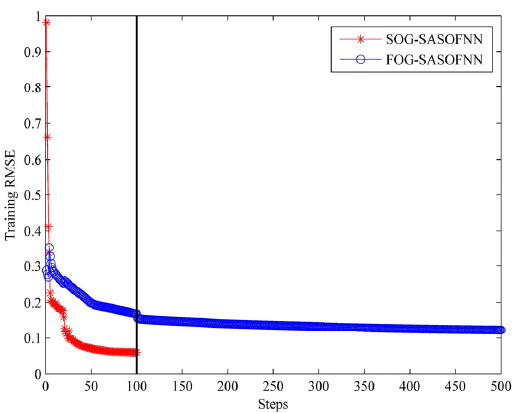
Figure 5. Training root mean square error (RMSE) values of SOG-SASOFNN and FOG-SASOFNN.